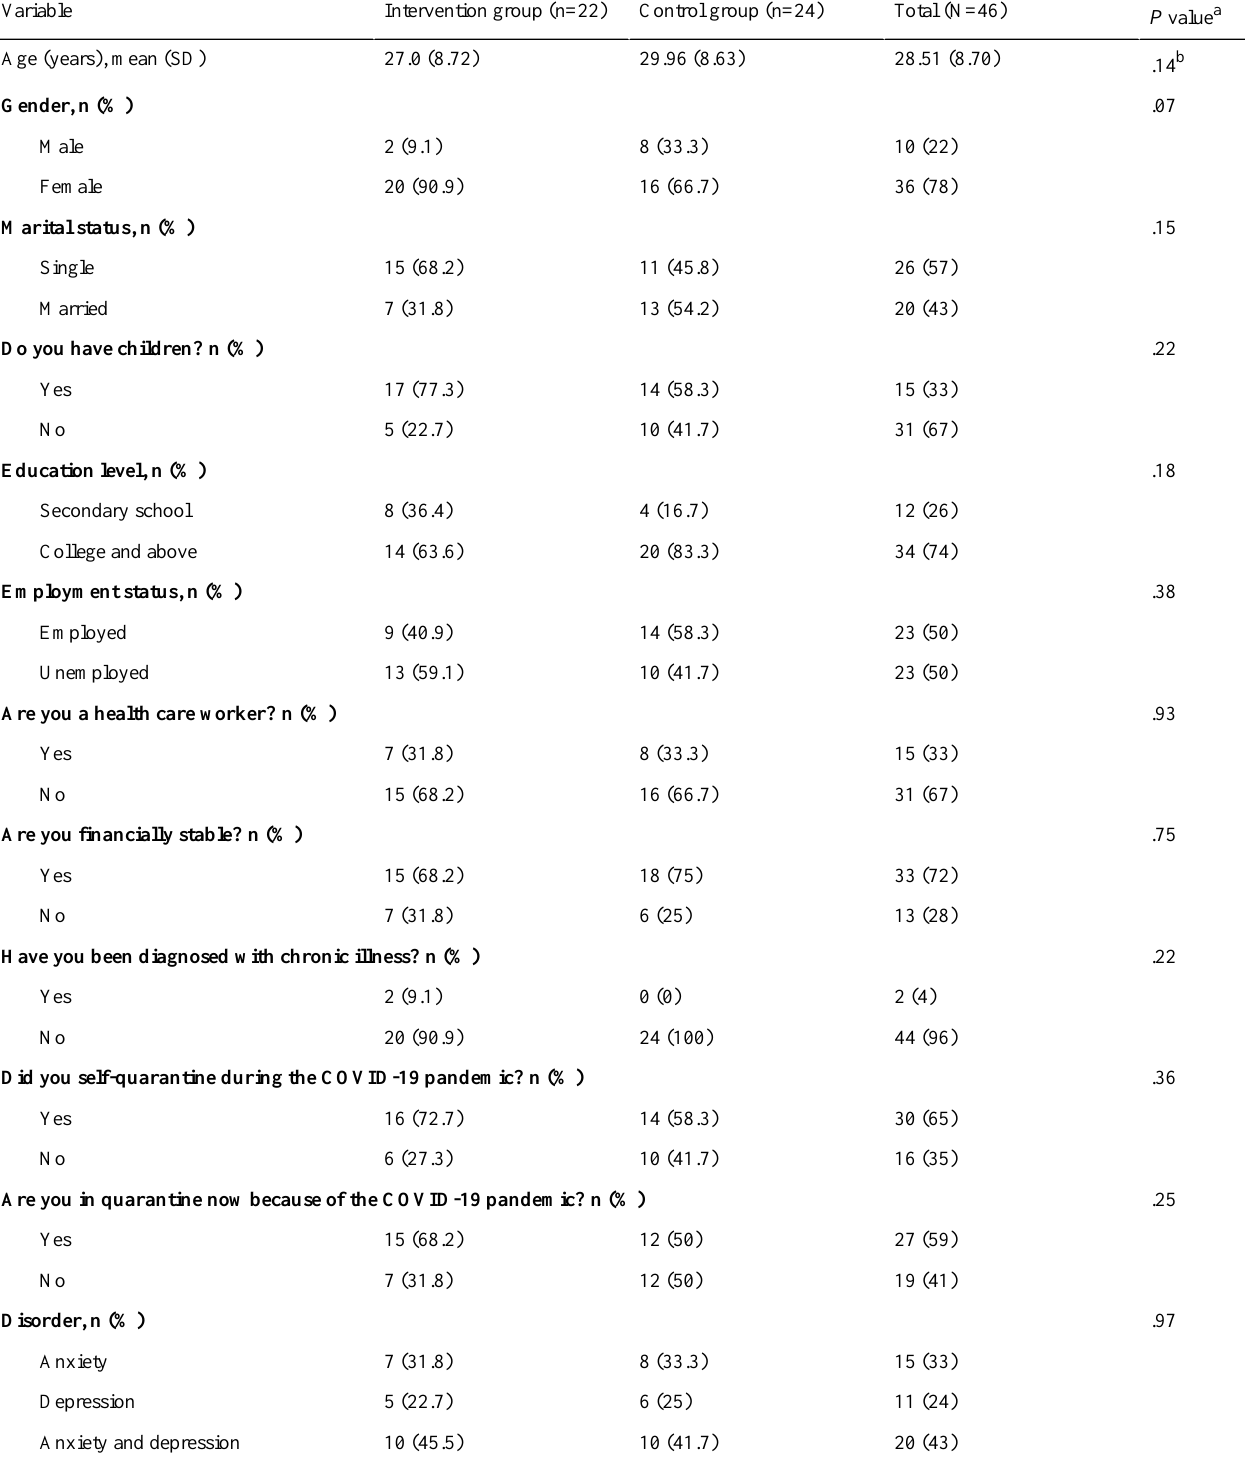
Table 1. Baseline characteristics of the participants in the randomized control trial (N =